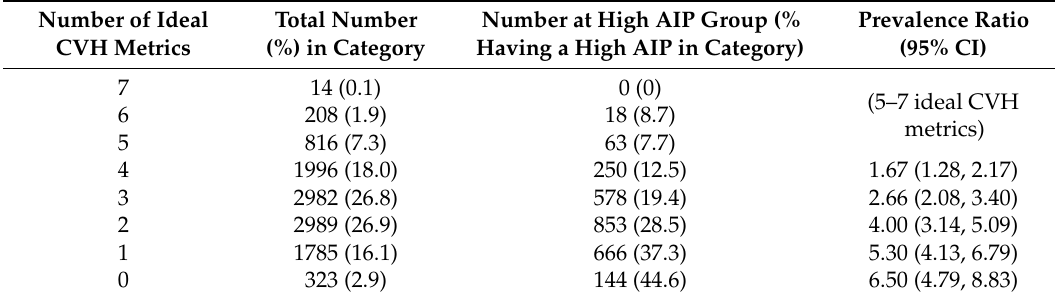
Table 4. Prevalence and prevalence ratios of having a high AIP according to number of ideal CVH metrics a .